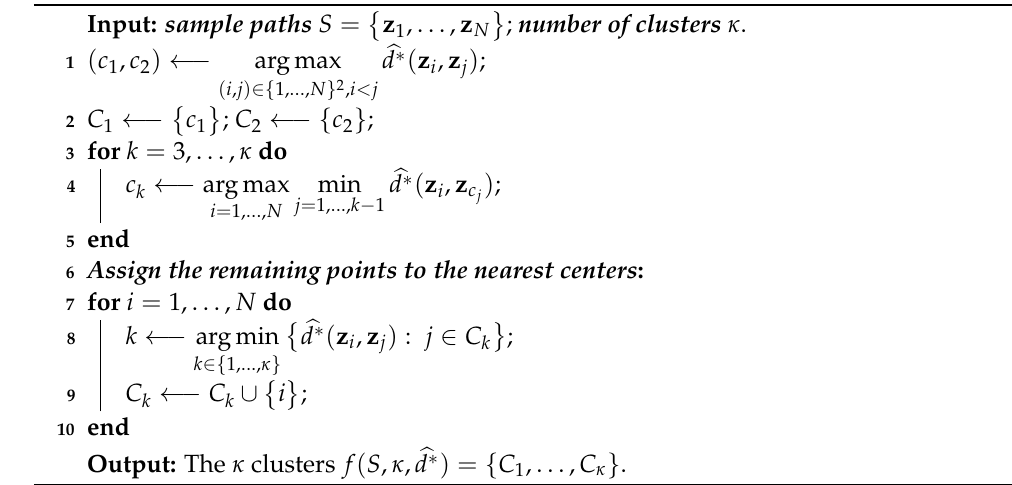
Algorithm 1: Offline clustering.